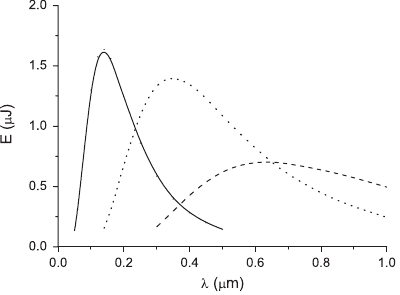
right.FIG. 7. Radiation pulse energy within a central cone of the SASE1 afterburner undulator versus wavelength for the R 56 of the dispersion section equal to 50 (cid:4) m (solid), 200 (cid:4) m (dotted), and 500 (cid:4) m